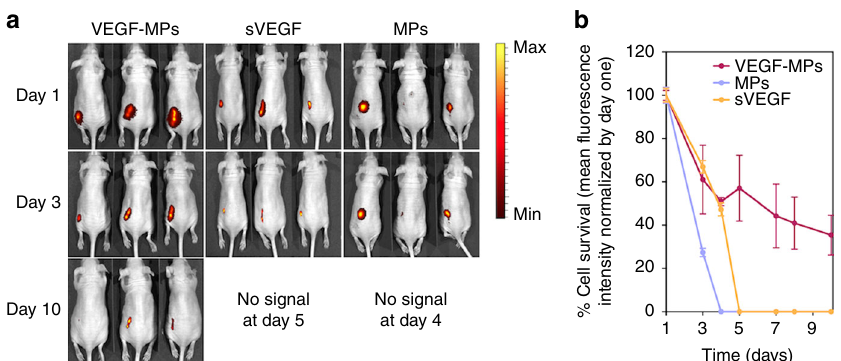
Fig. 3 OEPC aggregates containing VEGF-MPs improve in vivo survival. OEPC aggregates were prepared with sVEGF, blank MPs or VEGF-MPs and implanted subcutaneously. a Representative IVIS images and b fl uorescence intensity measurements of mice following injection of cell aggregates containing 1 million GFP-labeled OEPCs with sVEGF, blank MPs, or VEGF-MPs. The fl uorescence intensities were normalized by day one. Results are average ± SEM ( n